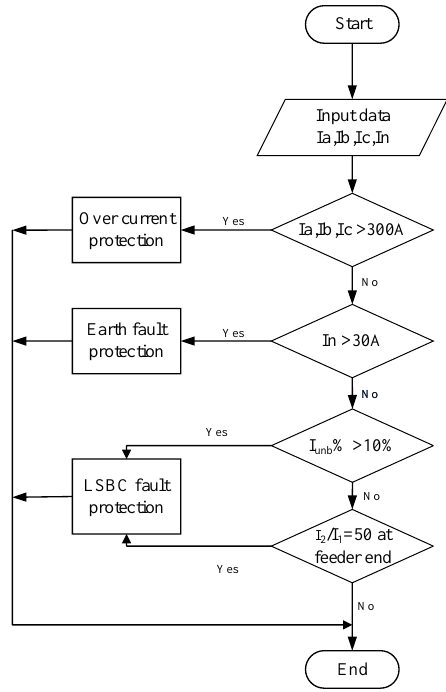
Figure 7. The flow chart of the proposed method.